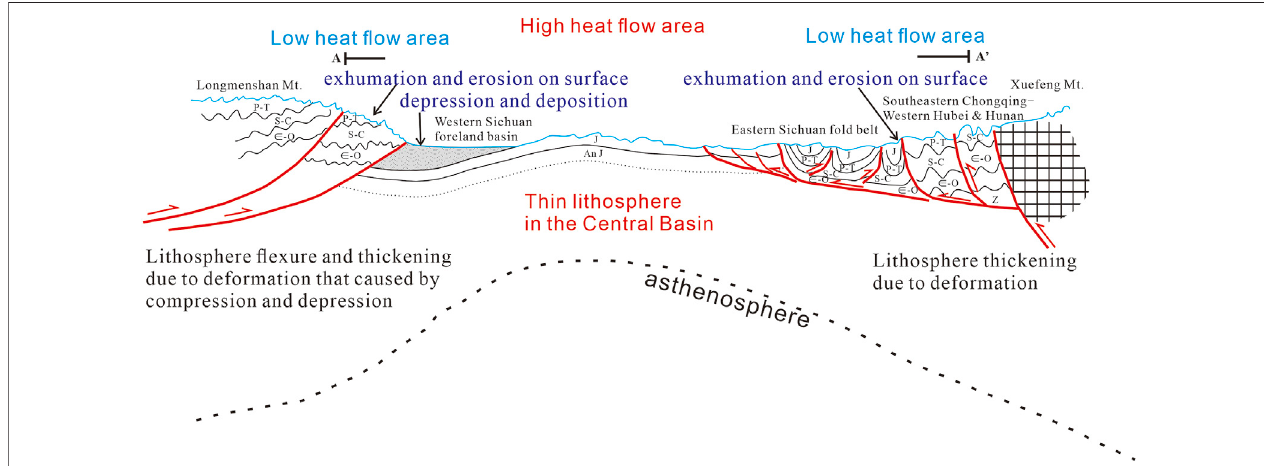
FIGURE 4 | Cartoon shows the main controlling factors on the unevenly distribution of geothermal fi eld in the Sichuan Basin and its surrounding mountains (the geological model was modi fi ed after Zhu et al., 2019).